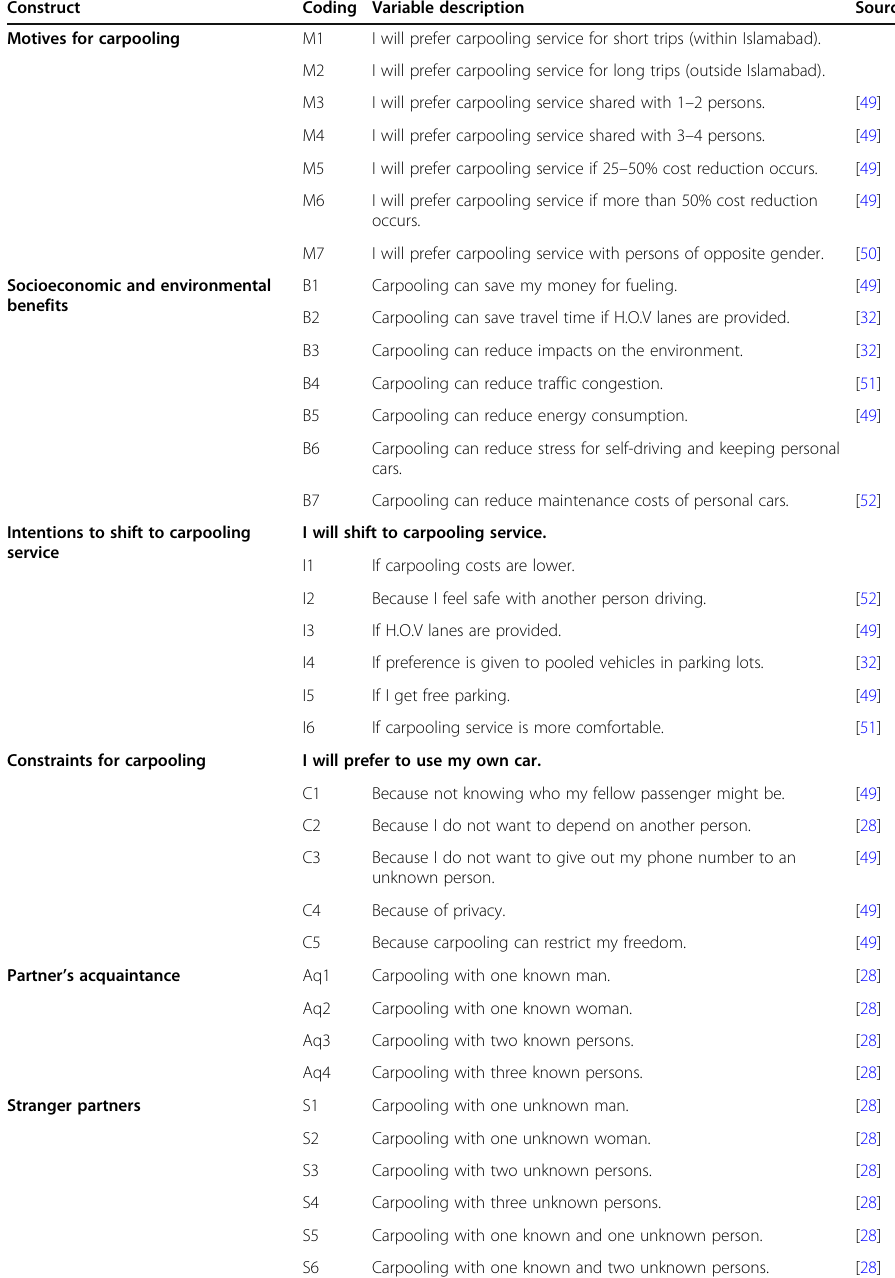
Table 1 Coding and descriptions of the items in the questionnaire measured on a Likert scale Construct Coding Variable description Source Motives for